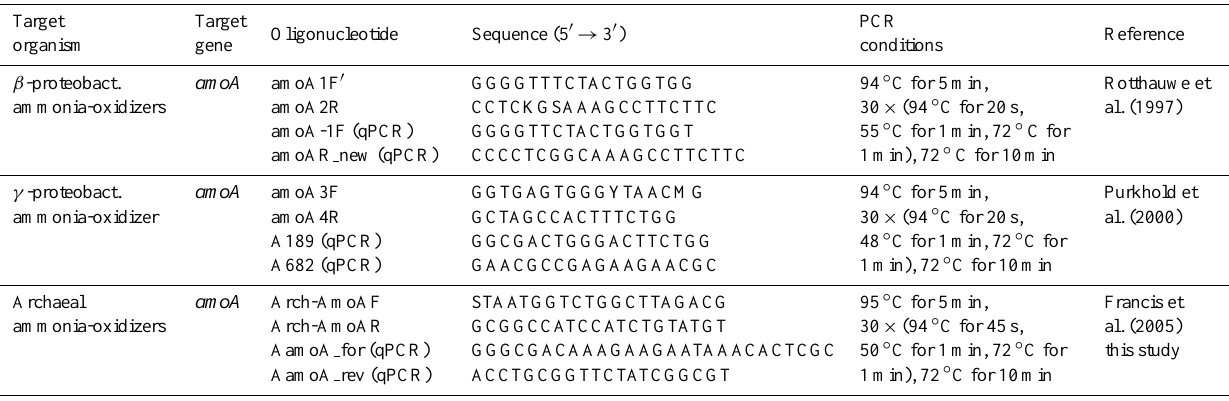
Table 1. Primers and PCR conditions: for real-time qPCR the initial denaturing step was 10min at 95 ◦ C, annealing temperatures were the same as in the end point PCRs, no final extension step took place, 40 cycles were performed followed by melting curve analysis. A fragment of 175bp was amplified in qPCRs of archaeal amoA